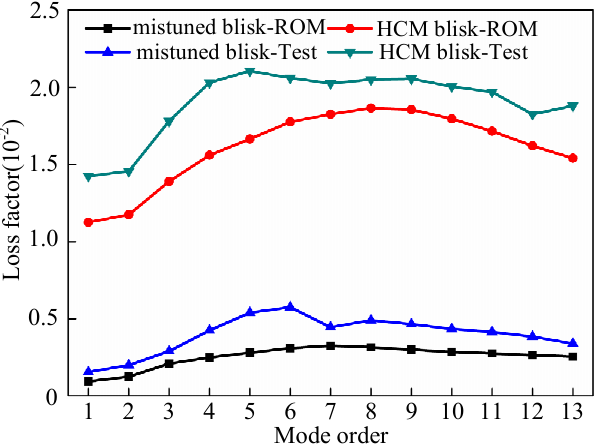
Figure 8. Modal loss factors of the mistuned blisk and HCM blisk.